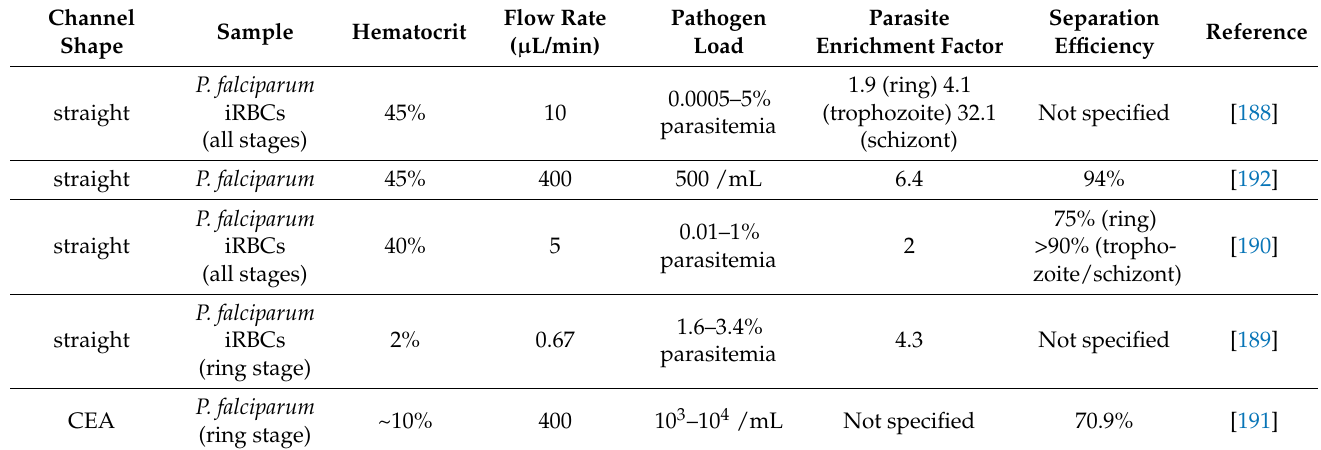
Table 4. Summary of parameters and performance of devices used for parasite